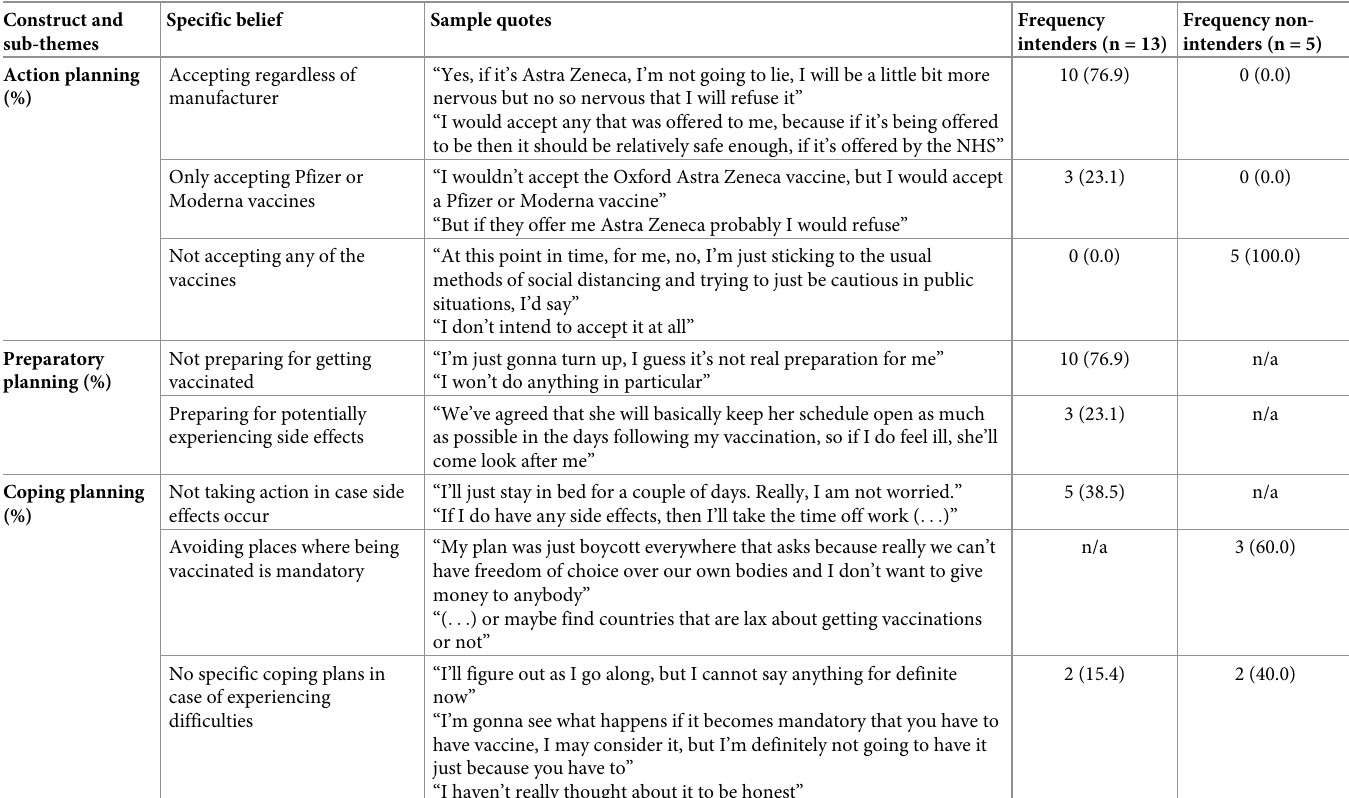
Table 4. Action phase